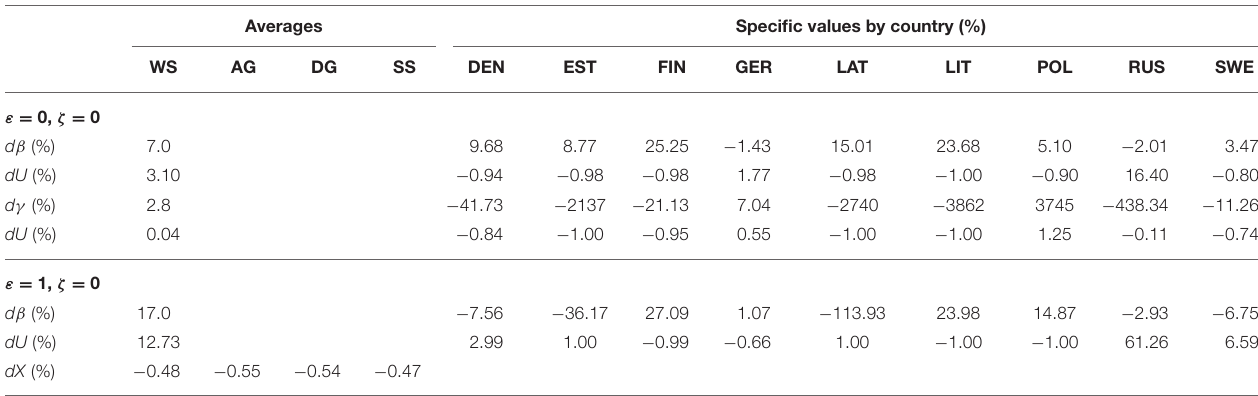
TABLE 7 | Baltic Sea: cooperative solutions. Averages Specific values by country (%)